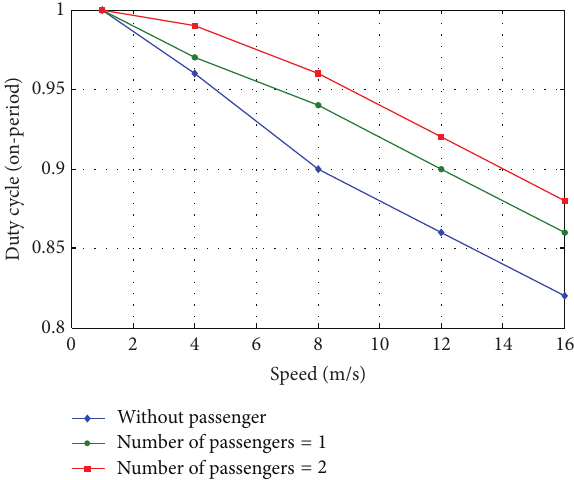
Figure 10: Effect of speed on the on-period of the duty cycle